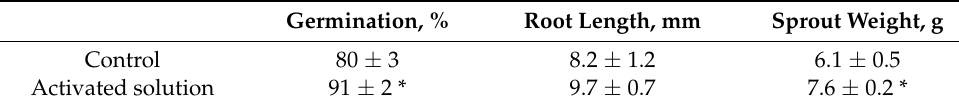
Table 4. Main parameters of young sorghum sprouts 120 h after